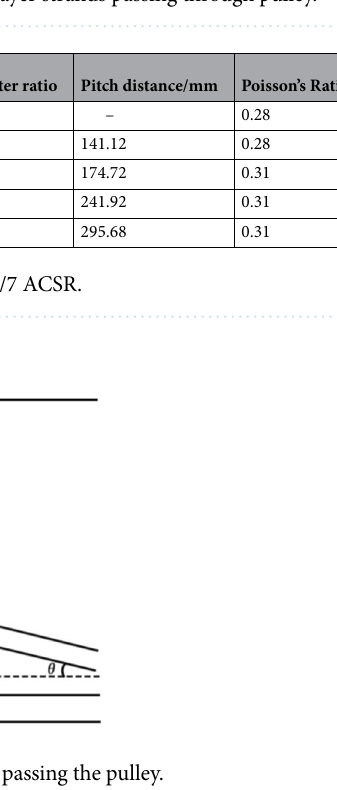
Figure 6. Finite element model of the conductor passing through pulley ( a ) The model of the same layer strand passing through pulley; ( b ) The model of adjacent layer strands passing through pulley.